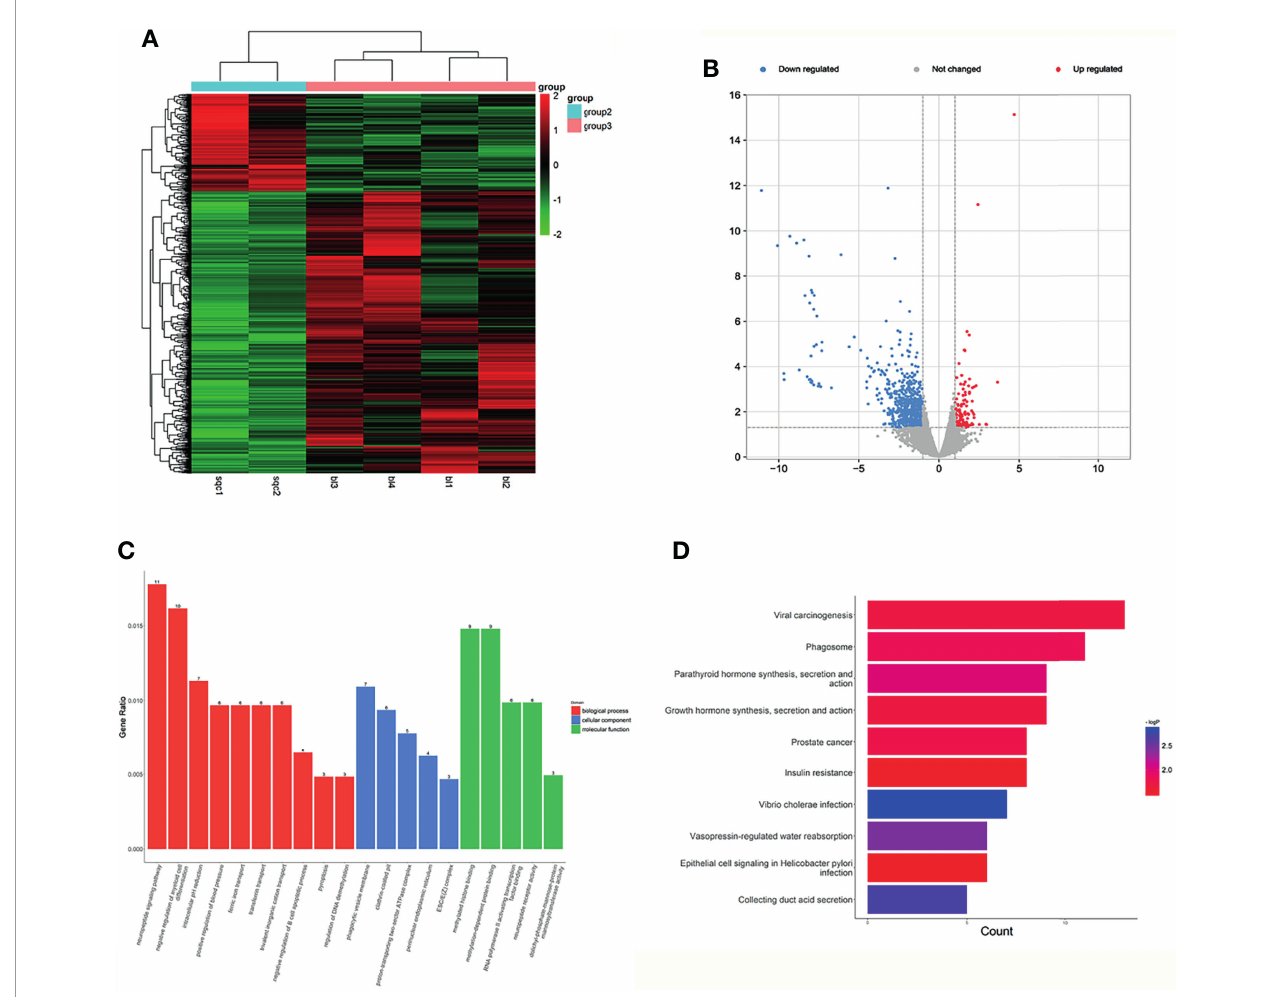
FIGURE 4 | Expression pro fi les of lncRNAs in plasma between LUSC patients and negative controls. (A) Heatmap of differentially expressed lncRNAs in LUSC patients and LUH patients (group 2, LUSC plasma; group 3, LUH plasma). (B) Scatter plot of differentially expressed lncRNAs. (C) Enrichment analysis of GO terms and pathways of the differentially expressed lncRNAs. (D) KEGG pathway analysis of the differentially expressed mRNAs between two